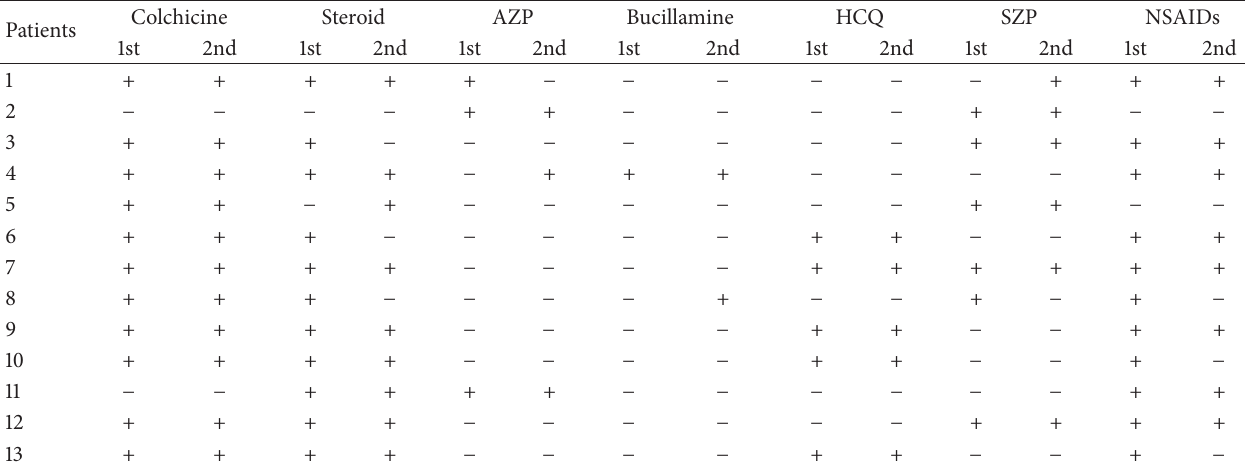
Table 2: Medications during the blood sampling in Behc¸et’s disease patients with arthritis.